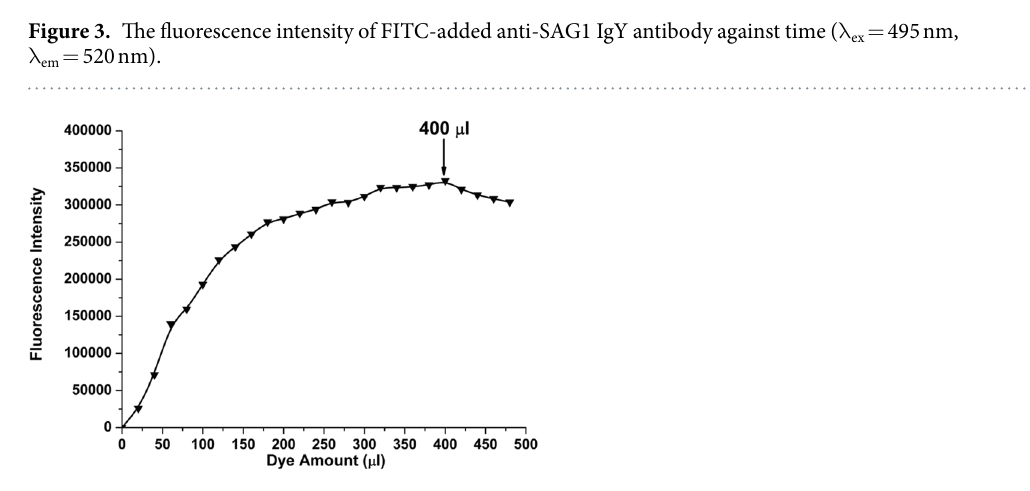
Figure 4. The fluorescence intensity of FITC-added anti-SAG1 IgY antibody against increasing amounts of FITC dye ( λ ex = 495 nm, λ em = 520